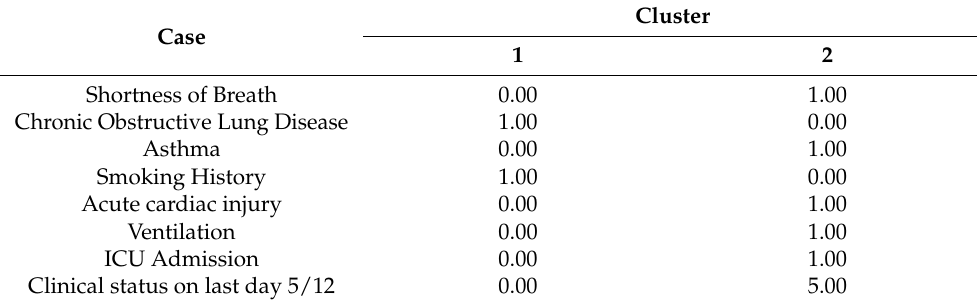
Table 6. Initial cluster